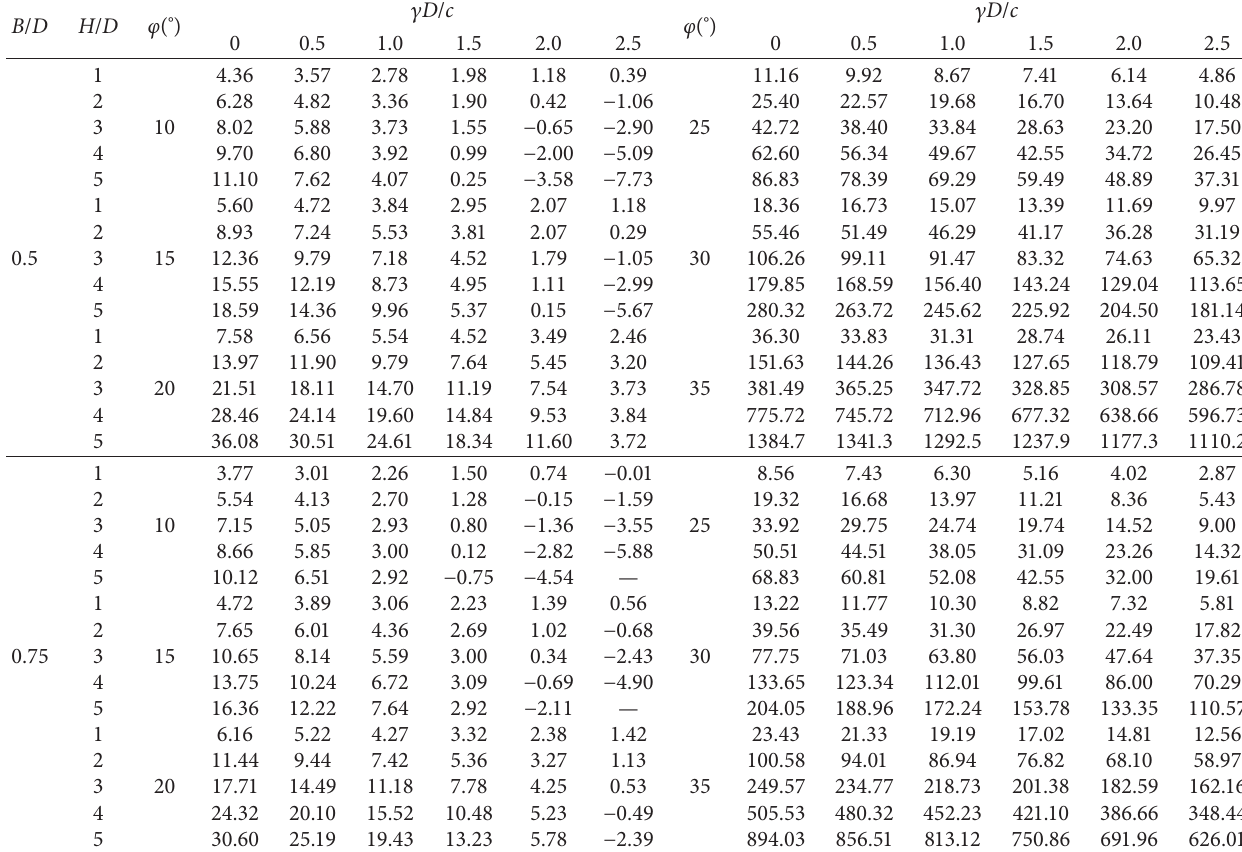
Table 2: Stability numbers ( σ s / c ) for an unlined rectangular